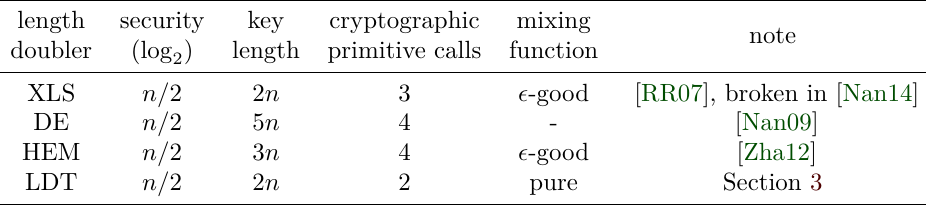
Table 1: Comparison of LDT with existing length doublers. Below we equate universal hash function calls with block cipher and tweakable block cipher calls as a heuristic for efficiency, however the relative efficiency of each of these primitive calls depends on the